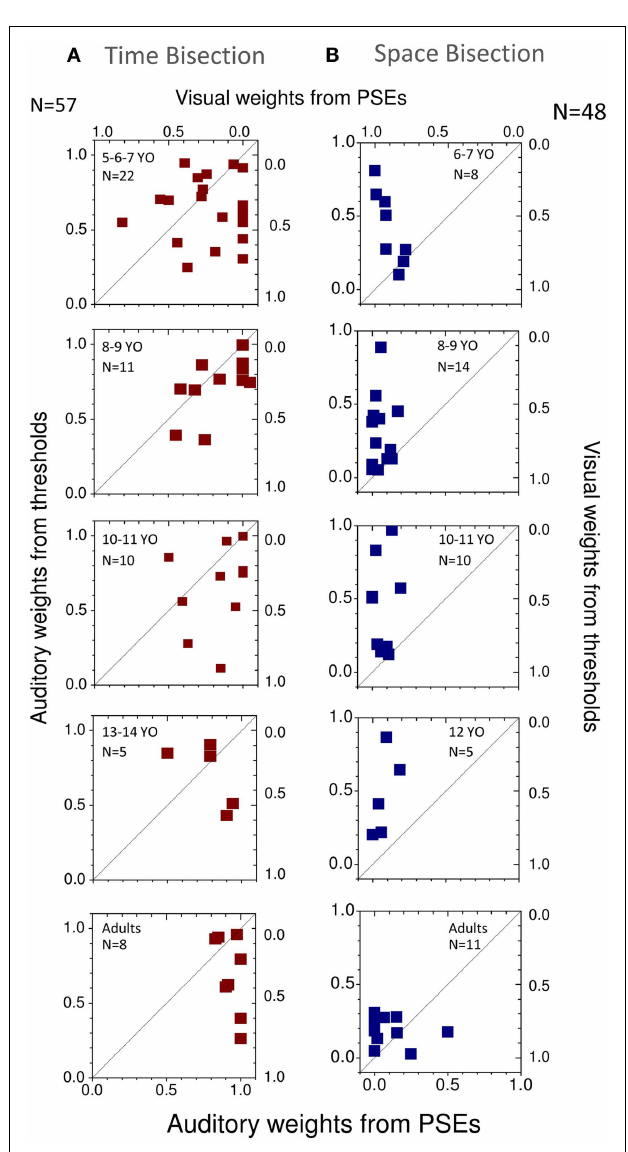
FIGURE 6 | (A) Individual weights predicted from thresholds plotted against those predicted from PSEs for different ages for the time bisection task.The black line shows the equality line. (B) Same for the space bisection